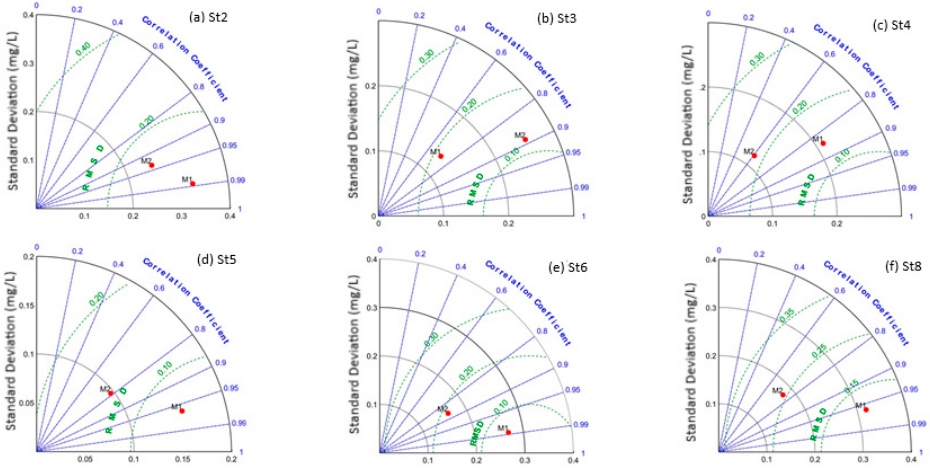
Figure 21. Taylor diagrams for SC1 (M1) and SC2 (M2), for carbon phytoplankton, PC, and the lagoon stations: ( a ) St1, ( b ) St3, ( c ) St4, ( d ) St5, ( e ) St6 and ( f )